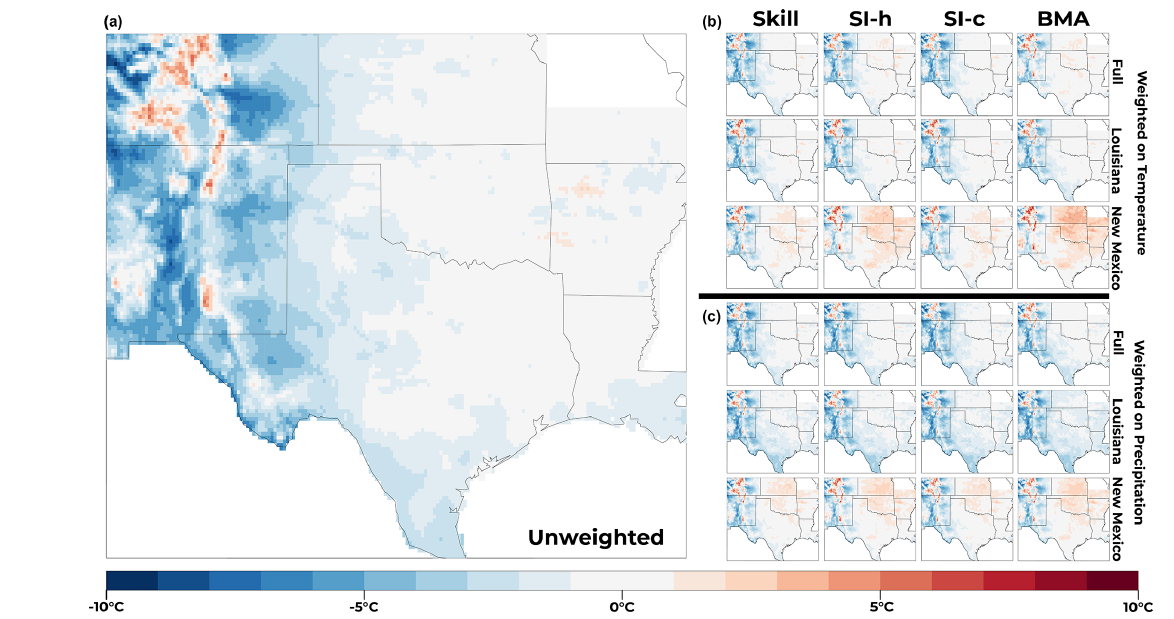
Figure 10. Same as Fig. 8, but for the bias of high temperature of the CMIP5 ensemble.